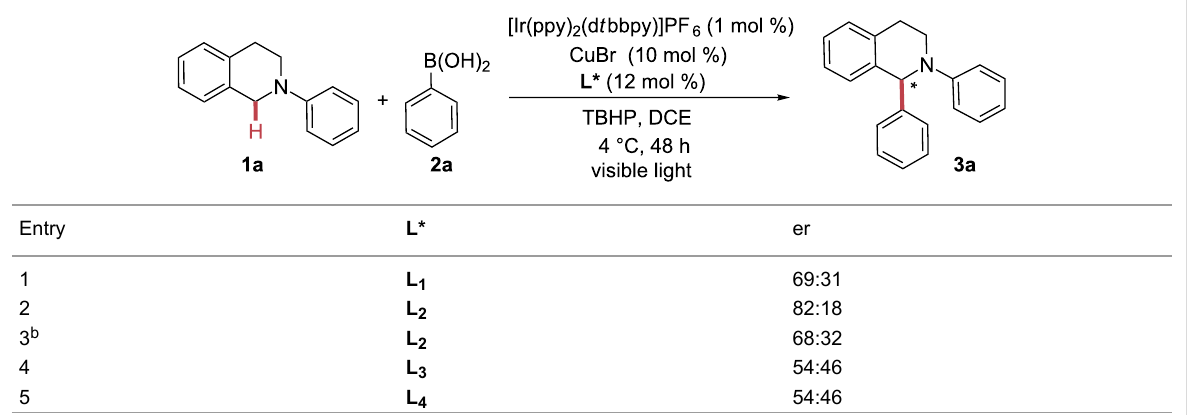
Table 2: Effect of chiral ligand on the enantioselectivity of coupling of N -phenyltetrahydroisoquinoline with phenylboronic acid a .